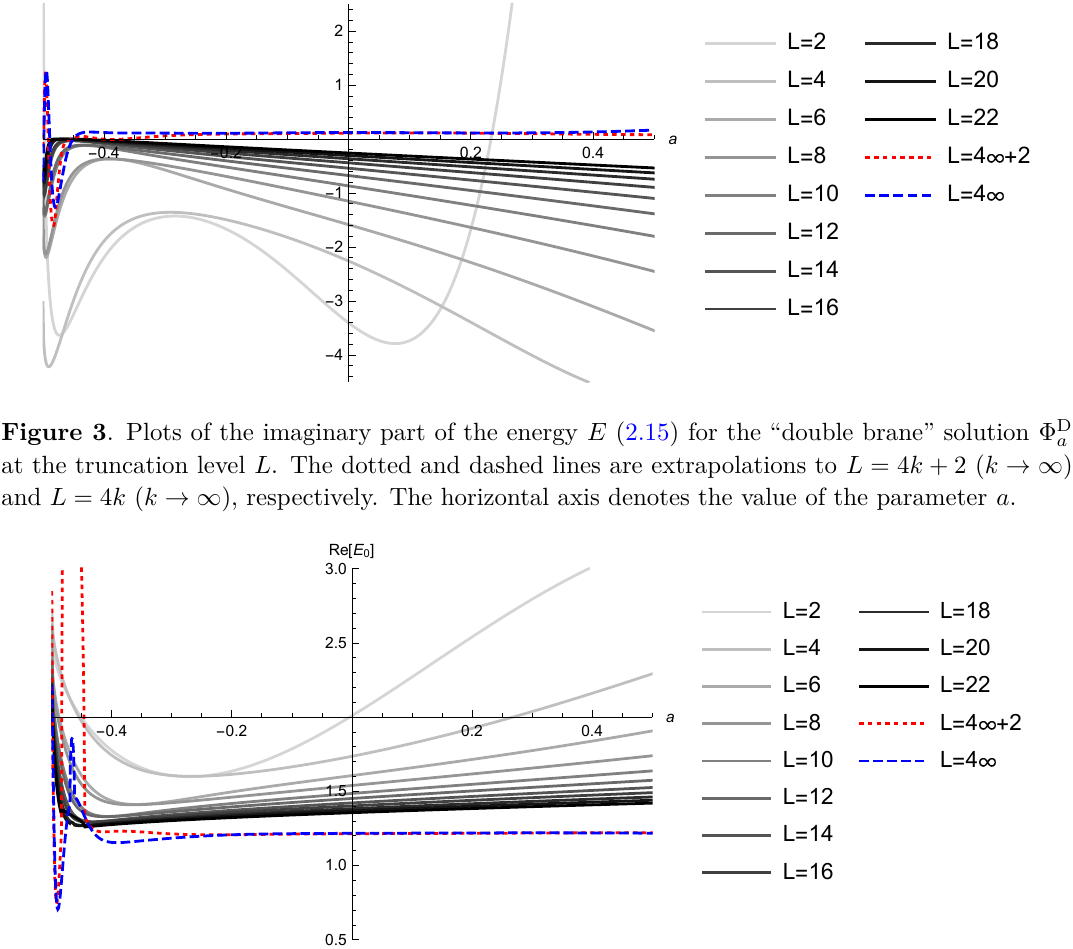
Figure 4 . Plots of the real part of the gauge invariant observable E 0 (2.17) for the “double brane” solution Φ D at the truncation level L . The dotted and dashed lines are extrapolations to L = 4 k +2 a ( k → ∞ ) and L = 4 k ( k → ∞ ), respectively. The horizontal axis denotes the value of the parameter a at Re E 0 = 2